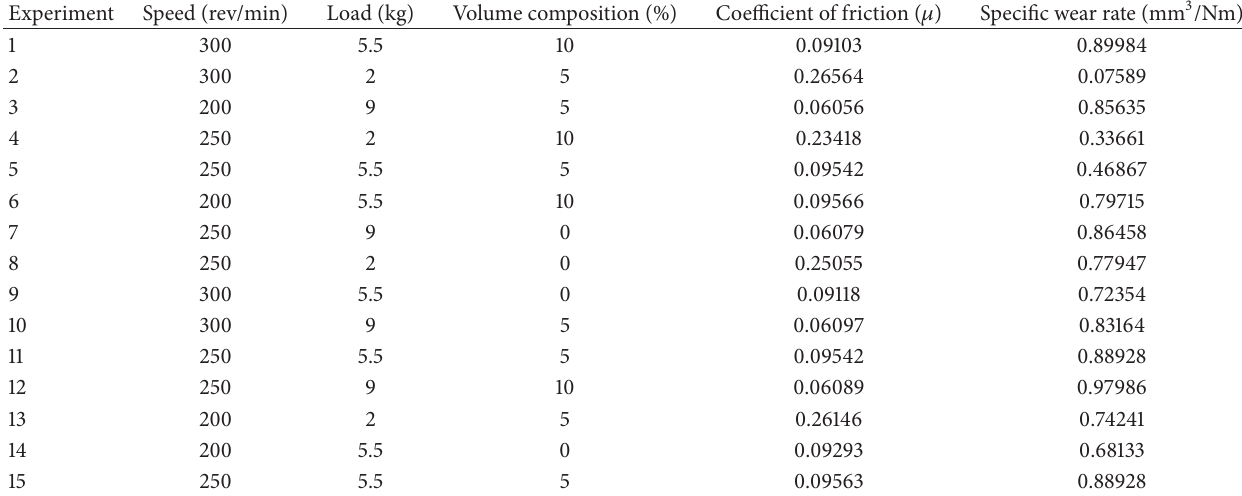
Table 6: Experimental design and results (uncoded factors).